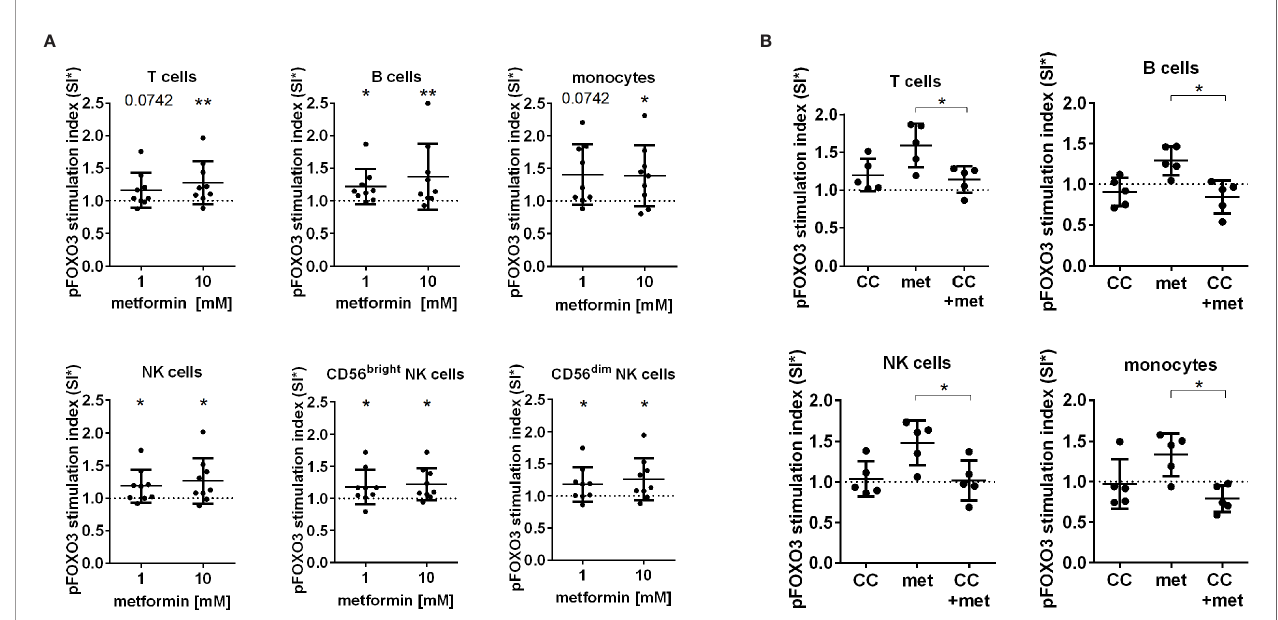
FIGURE 2 | FOXO3 is activated by metformin in an AMPK dependent manner. (A) FOXO3 (pS413) expression in T cells, B cells, monocytes and NK cells (total, CD56dim and CD56bright) after 30 min stimulation analysed by fl ow cytometry. (B) Addition of the AMPK inhibitor Compound C (CC) [10 µM] abrogated the effect of 10 mM metformin. SI: The MFI (AF700) of FOXO3 (pS413) expression subtracted by background signal (GAR) is depicted in relation to the unstimulated control. Median with interquartile range is shown. Wilcoxon test is used for statistical analysis in relation to unstimulated control or between indicated groups. *P ≤ 0.05, **P ≤